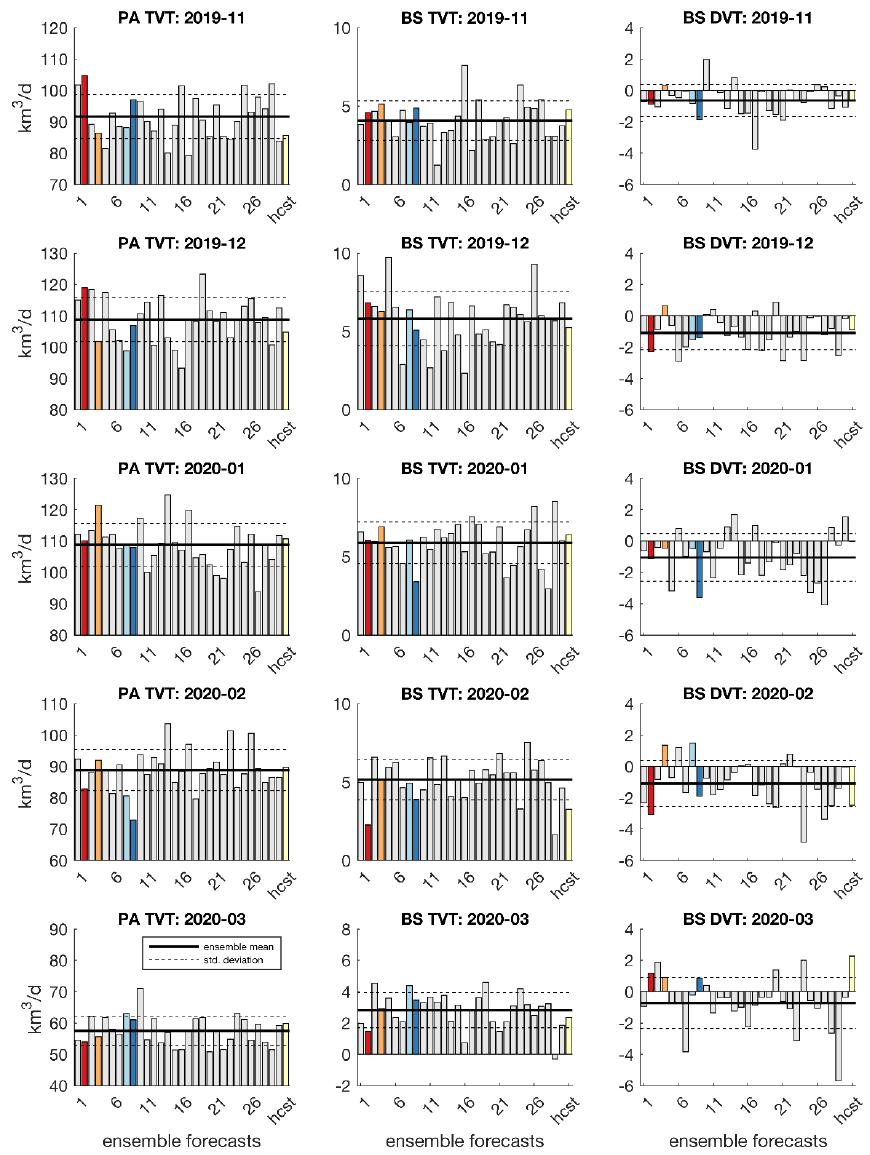
Figure 14. Thermodynamic sea ice volume tendencies (km 3 d − 1 ) for all 30 ensemble members and the RASM hindcast simulation (yellow) for the pan-Arctic (left column) and the Barents Sea (middle column) along with the combined ice-growth and ice-melt terms and the dynamic sea ice volume tendencies (km 3 d − 1 ) for the Barents Sea (right column). Four individual ensemble forecast members are selected: members 2 (red), 4 (orange), 8 (light blue) and 9 (dark